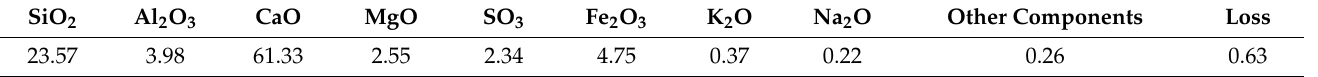
Table 1. Chemical composition of PLH42.5 (wt.%).